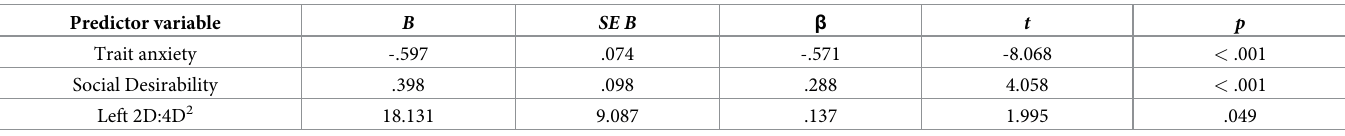
Table 5. Regression model of emotional